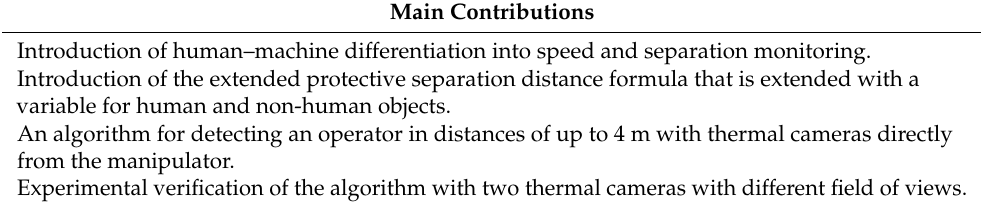
Table 1. List of main contributions of this